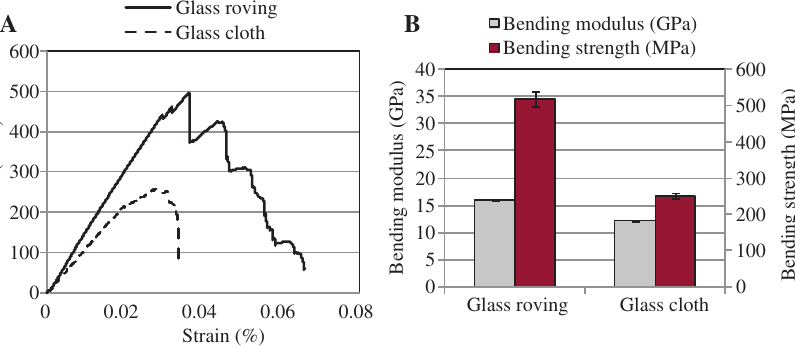
Figure 6 Three-point bending test results: (A) stress-strain curves and (B) modulus and strength